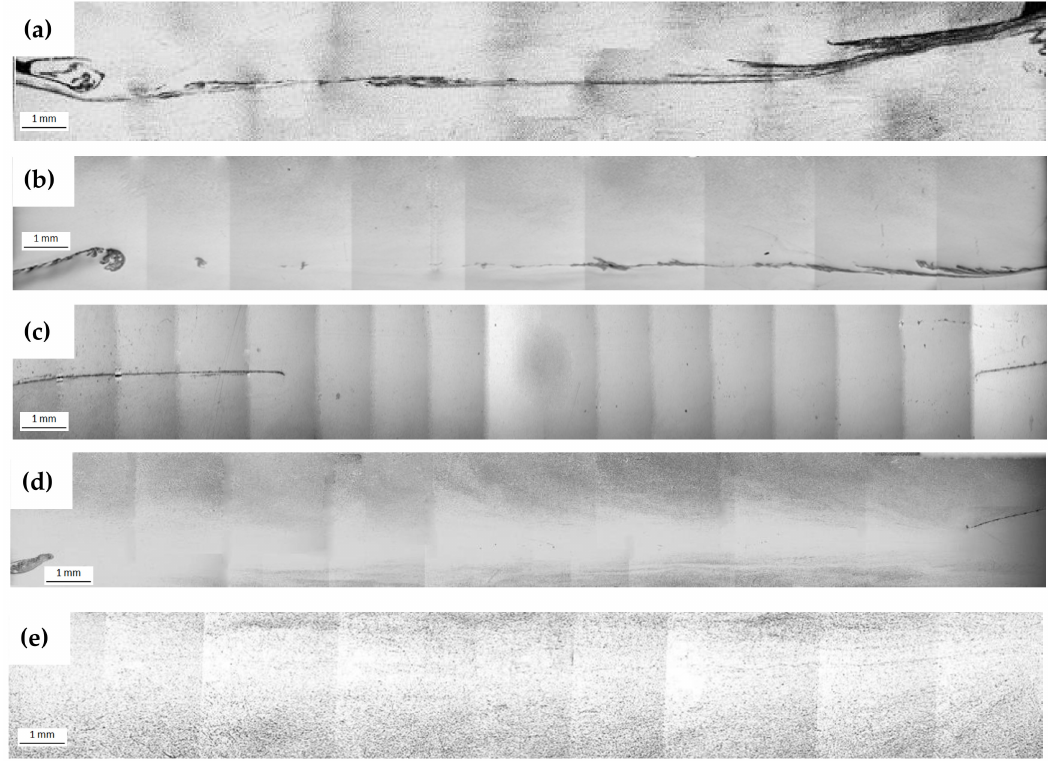
Figure 3. Overall view of as-LFWed joints by OM: ( a ) No. 6, ( b ) No. 9, ( c ) No. 10, ( d ) No. 11, and ( e ) No.